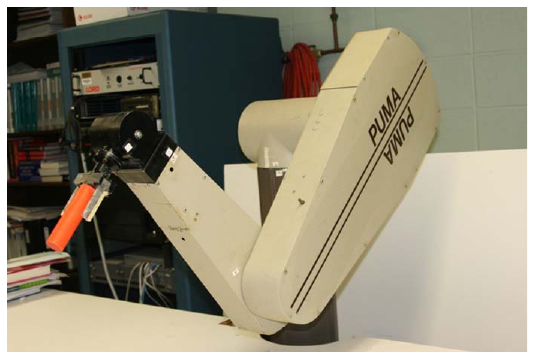
Figure 8. PUMA 560 robot in the experiment.